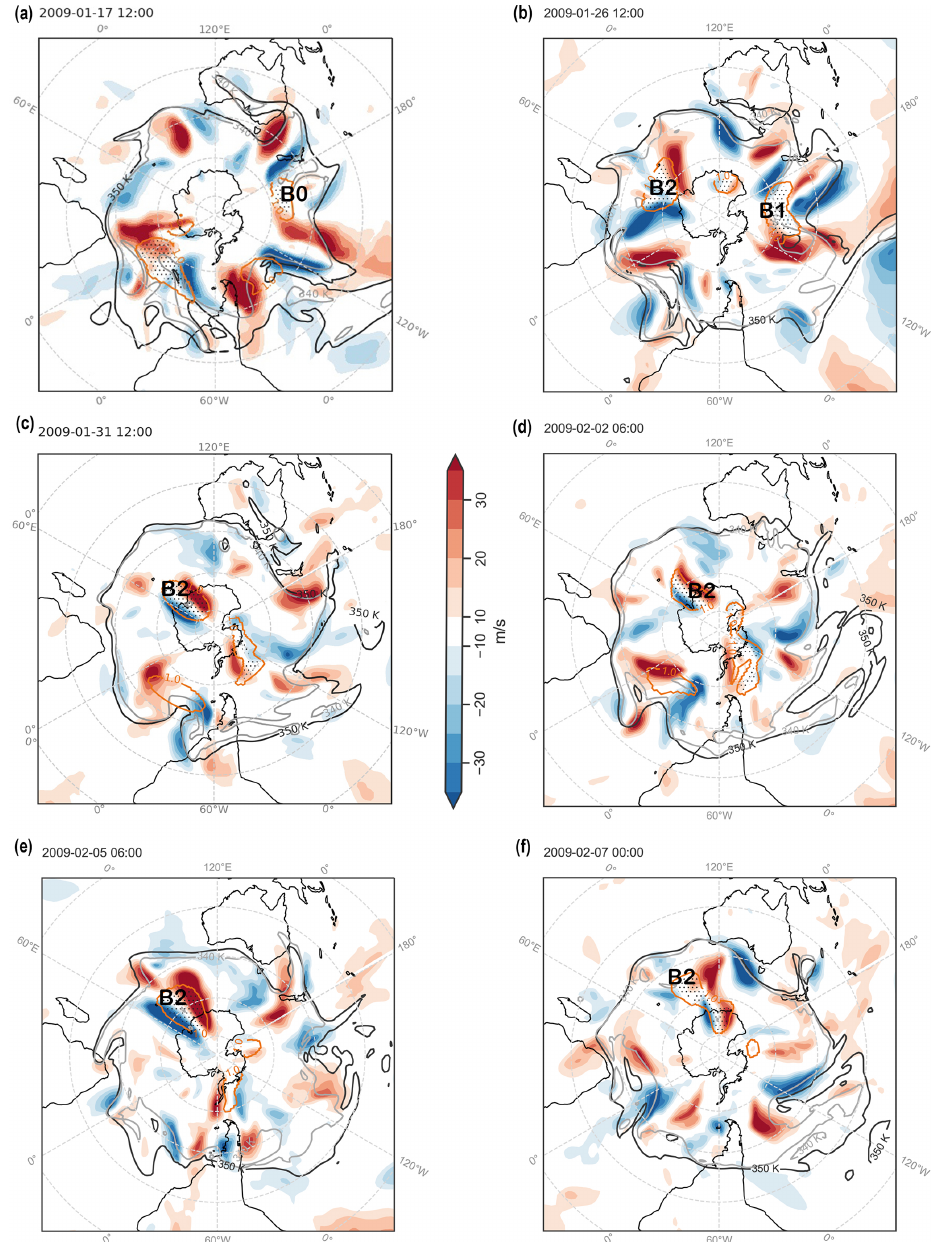
Figure 7. Same as in Fig. 5 except for the February 2009 SEA